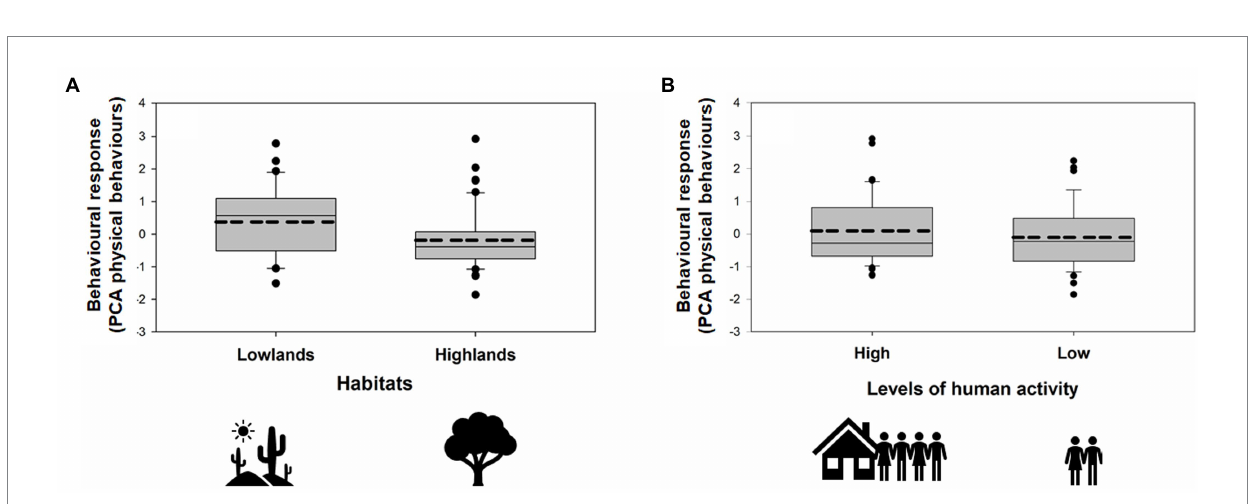
FIGURE 4 Behavioral playback responses of 82 resident males to the playback of conspecific intruder songs in relation to (A) habitat (lowlands, highlands) and (B) levels of human activity (high, low). The responses are shown as PCA scores (PCA Physical Behaviors) whereby higher scores indicate a stronger response to playback (a shorter latency to respond, a shorter minimum distance, more time spent close the speaker, many flights over the speaker). Horizontal lines within the boxes represent the means (hashed lines) and medians (straight lines). The upper and lower limits of the boxes show the 75th and 25th percentiles, respectively. Black circles indicate